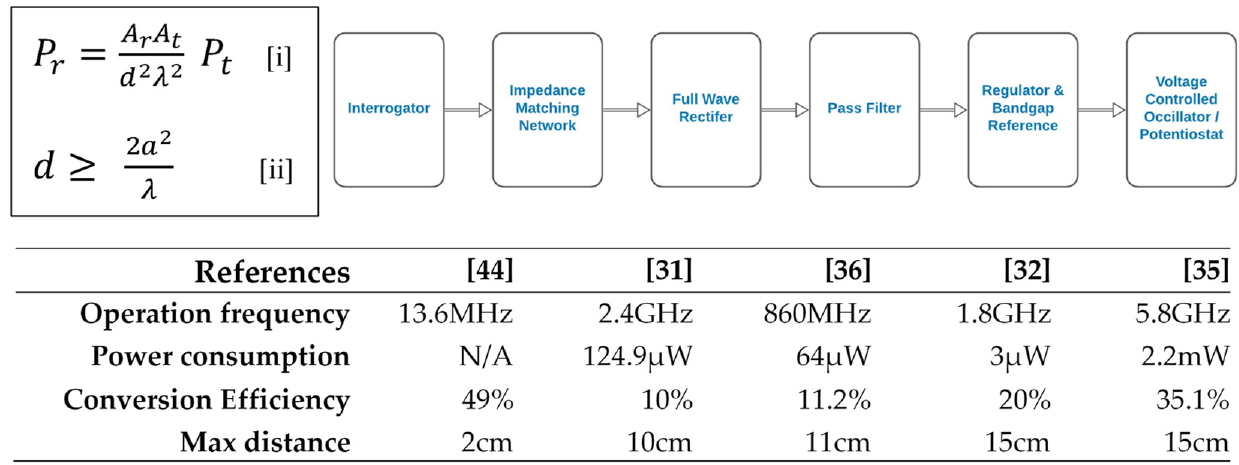
Figure 4. ( Upper left panel) By characterizing an antenna by its effective area instead of its power gain or radiation resistance, an estimation of the maximum power that can be obtained at the receiving antenna of a radio circuit in free space, assuming a plane wavefront, can be obtained (equations [i] and [ii]). Ar is the effective area of the receiving antenna, At is the effective area of the transmitting antenna, Pr is the power at the receiving antenna, Pt is the power at the transmitting antenna, d is the distance between the transmitter and receiver, λ is the wavelength of transmitted signal, and a is the maximum linear dimension of either antenna, respectively. ( Upper right panel) Stages of radiofrequency power transfer to contact lenses. ( Lower panel) Performance comparison for radiofrequency-powered contact lenses [31,32,35,36,44]–it is evident that the best result was achieved by the Cheng group [35]. This is because they met the minimum safe distance of 11 cm [34] and had a high conversion efficiency.